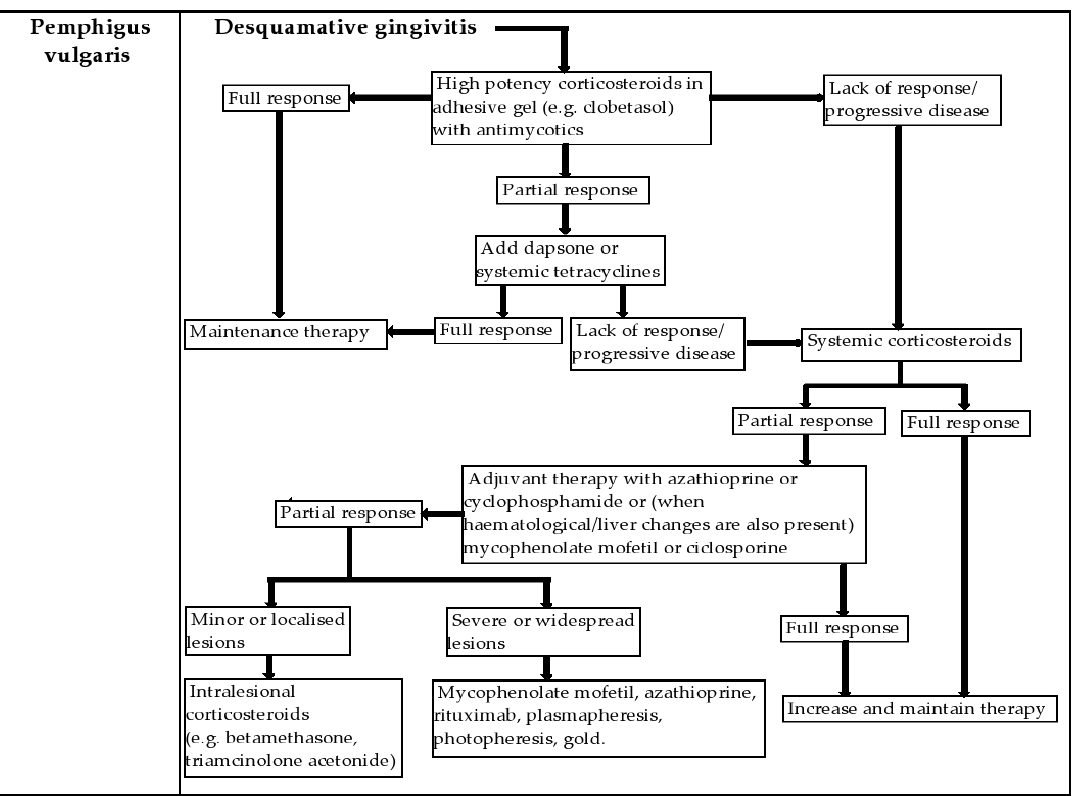
Figure 2. Treatment algorithm for desquamative gingivitis due to pemphigus vulgaris.